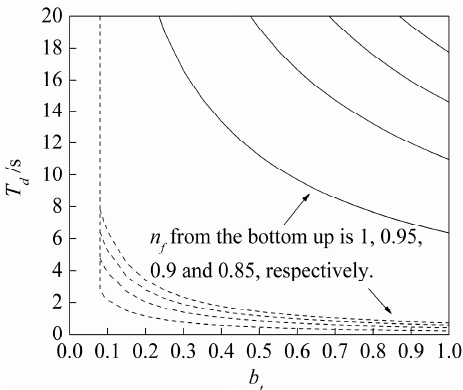
Figure 12. Effect of the sectional area of surge tank on stable domain under FR (solid line) and PR (dotted line) [65].